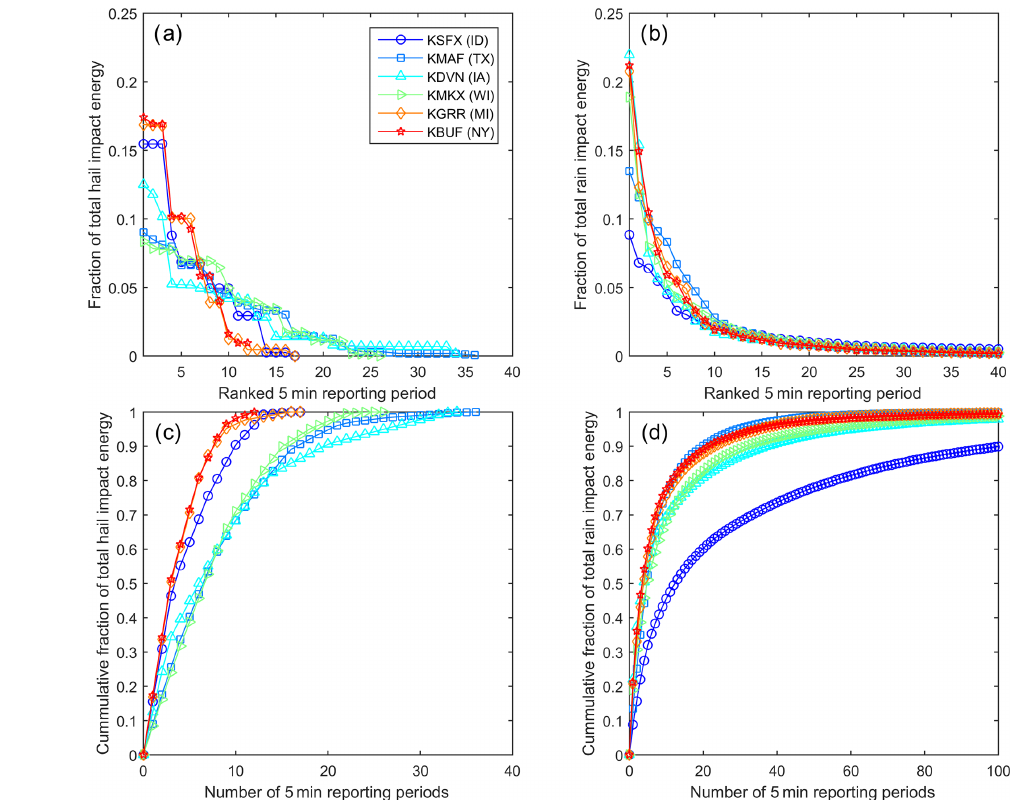
Figure 7. Contributions of the most intense precipitation events to annual total kinetic energy from hydrometeor impacts. (a) Contribution of the top forty 5min periods of hail as a fraction of the annual total kinetic energy of hail impacts. (b) Contribution of the top forty 5min periods of rain as a fraction of the annual total kinetic energy of rain impacts. Cumulative fraction of annual impact kinetic energy from the top X (c) hail events and (d) rain events, where X is set to 40 for hail because no site exhibits more than 36 events per year and is truncated to 100 for